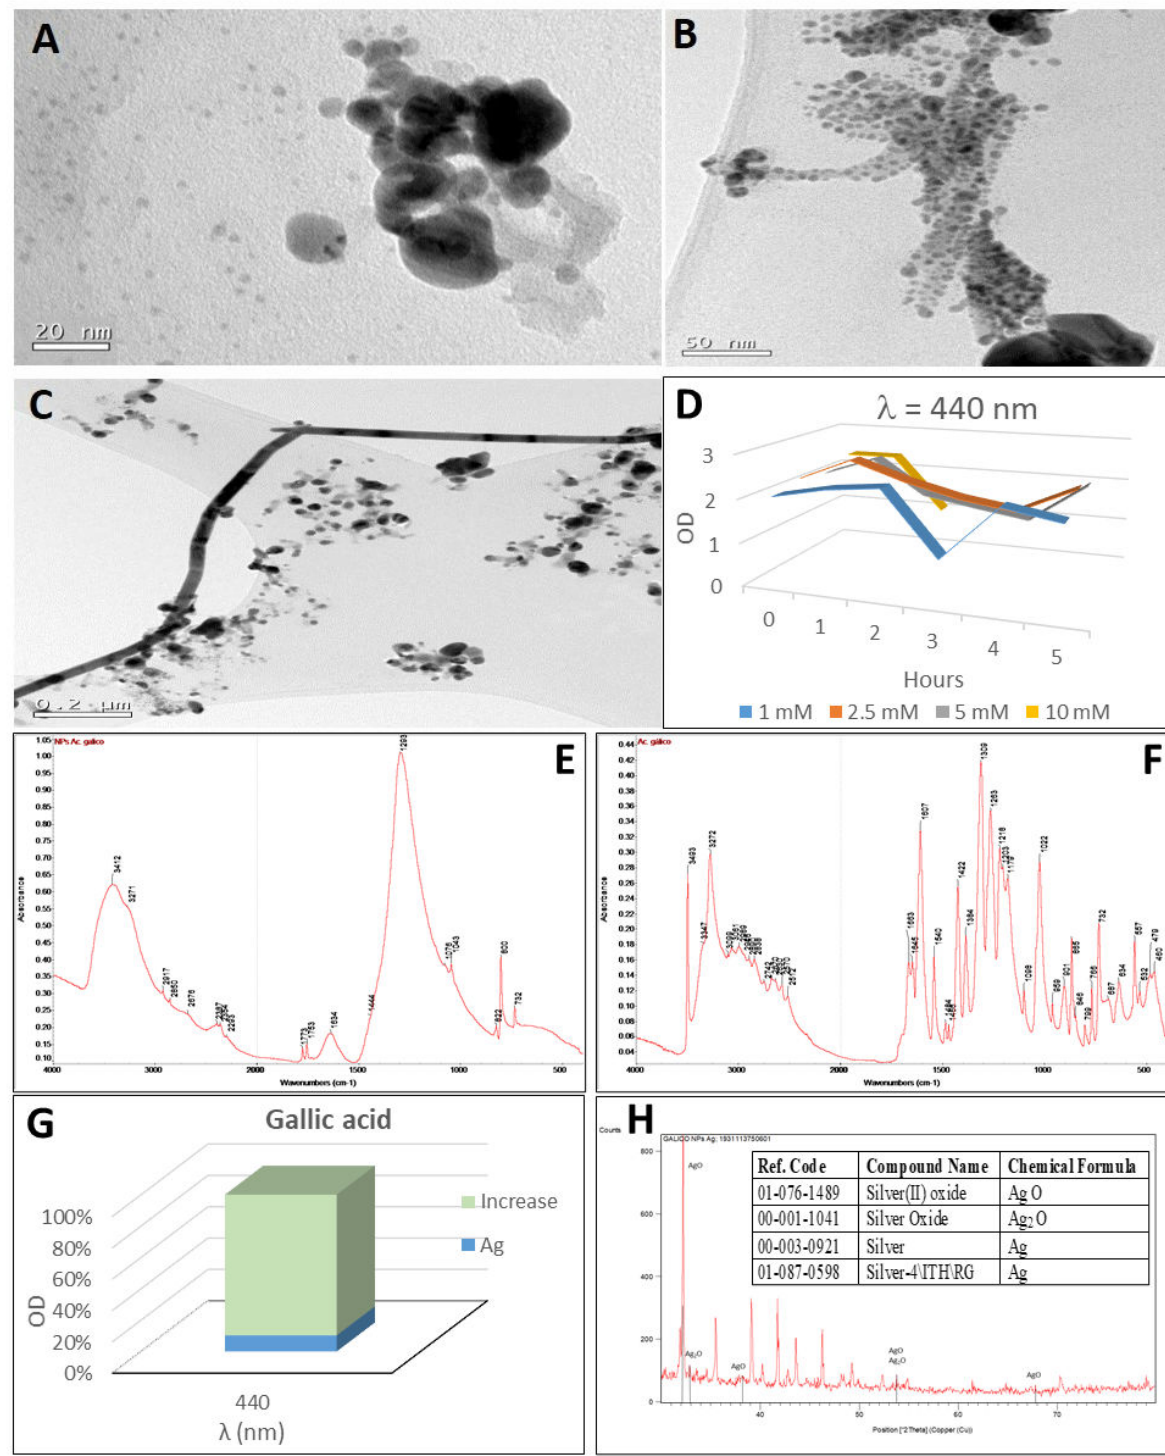
Figure 5. Analysis of silver nanoparticles synthesised with gallic acid. ( A ) TEM image of AgNPs. ( B , C ) TEM images of AgNPs after cyanide treatment. ( B ) Aggregation of nanoparticles prior to Figure 3. concentrations with gallic acid for 5 h (at one-hour intervals). ( D ) Synthesis of silver nanoparticles by the reaction of different AgNO 3 concentrations with gallic acid for 5 h (in one-hour intervals). ( E , F ) FTIR spectra of gallic acid-derived nanoparticles ( E ) and gallic acid ( F ). ( G ) Relative increase of OD after cyanide addition to silver nanoparticles. ( H ) XRD diffractogram of the AgNPs obtained by the reaction of gallic acid with Ag NO 3 ; in the insert, the table with the identifications. Peaks identifying the presence of silver oxides have been indicated in the XRD